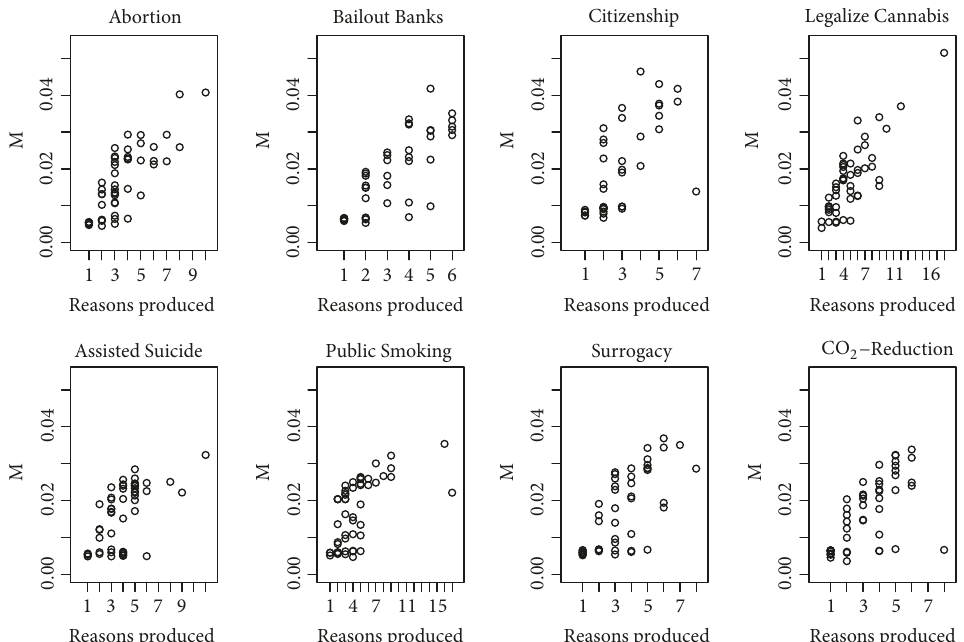
Figure 11: Mediation centrality 𝑀 of an individual (y-axes) plotted as a function of the number of reasons produced by that individual, separately for each policy issue.